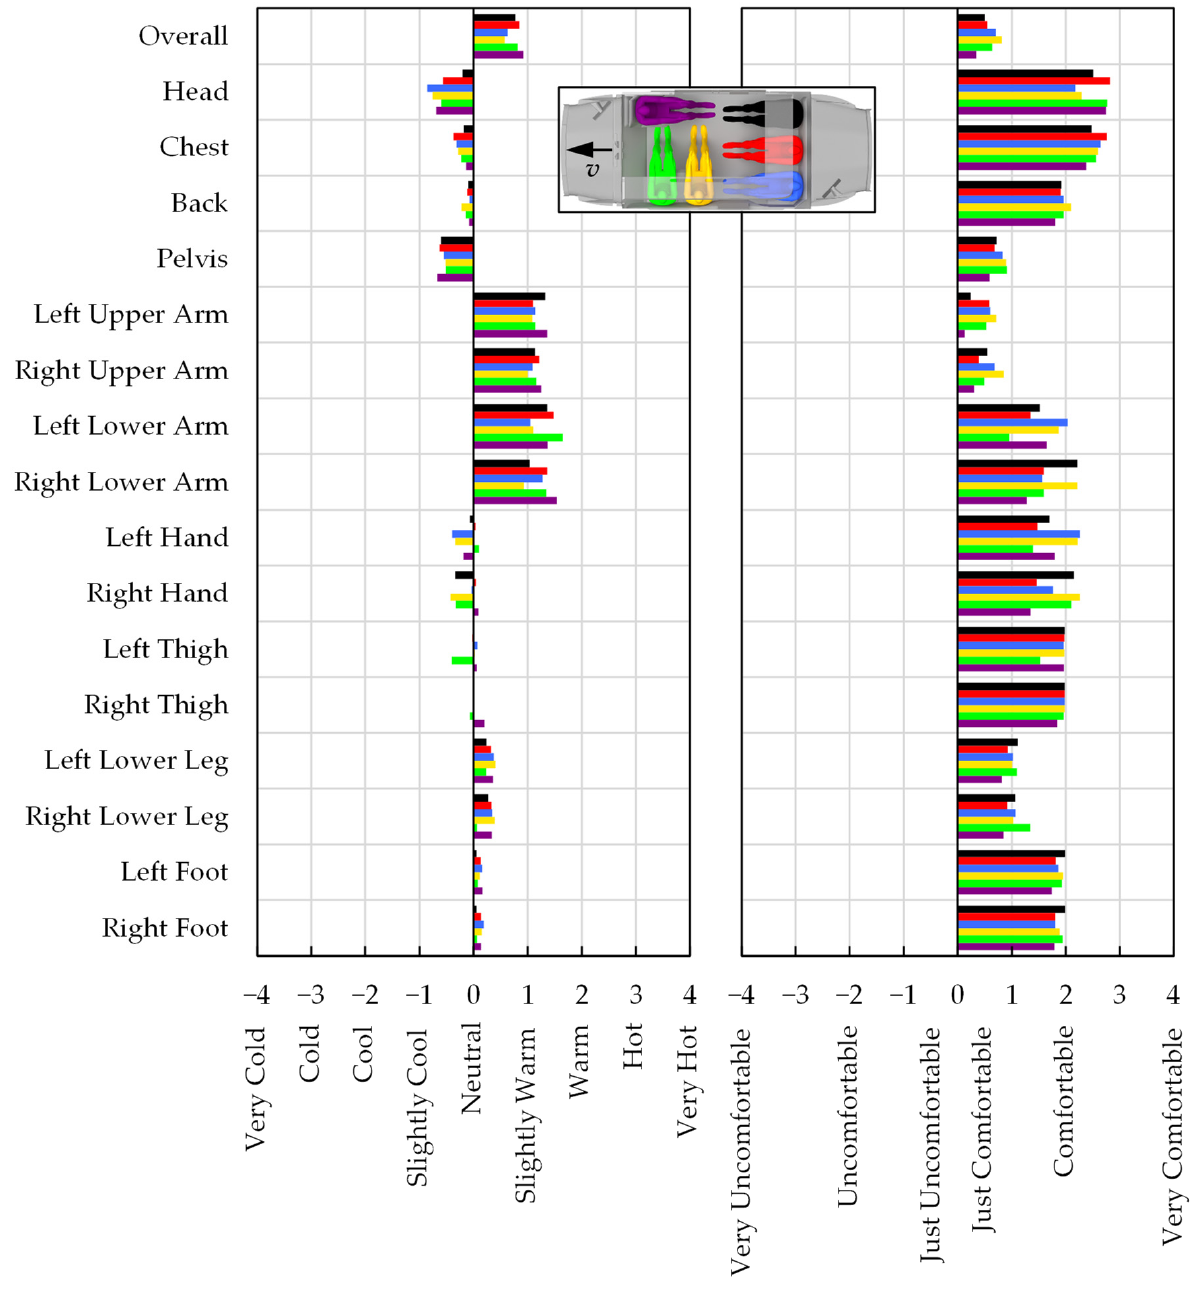
Figure 7. Simulated thermal sensation and comfort results of all occupants in the summer case.